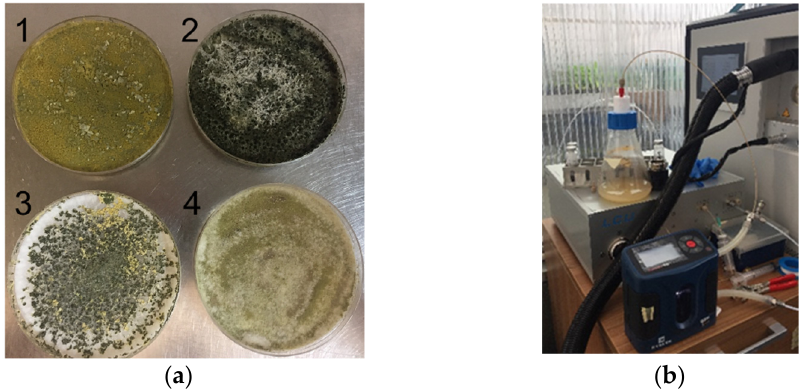
Figure 1. ( a ) Petri dishes containing Trichoderma isolates grown at 25 ± 1 °C in the dark for 14 days: 1: T. longibrachiatum MK1; 2: T. asperellum B6; 3: T. afroharzianum T22; 4: T. atroviride P1; ( b ) Erlen- meyer conicalglass flask equipped with a GL45 3-valve screw cap containing 100 mL of potato dex- trose agar (PDA) medium, connected online with PTR-Qi-TOF-MS.